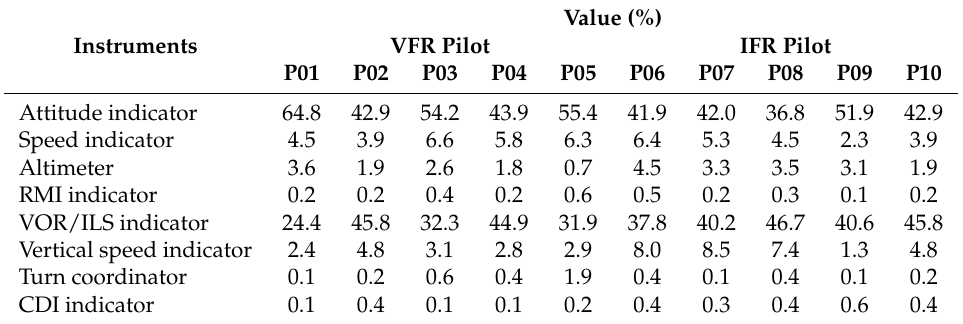
Table 11. Average percentage contribution of the duration of all fixations depending on the defined area based on the algorithm with instrument outline